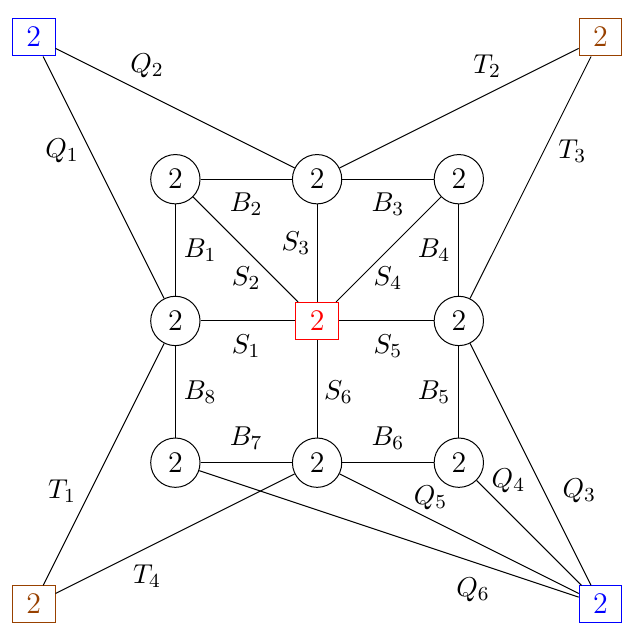
√ 2; 1 , 1 , 1 , 1 , 0 , 0) . In order to